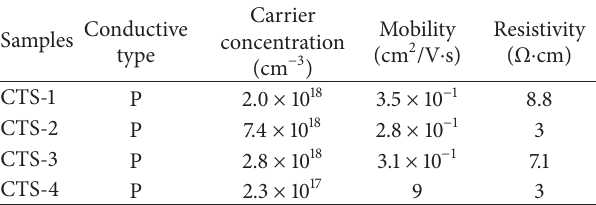
Figure 3: (a) Absorptance versus hv plot of the CTS-3 thin film. (b) The plots of ( 𝛼 hv ) 2 versus hv for estimating the direct band gap. Table 3: Electrical properties of the CTS thin films sulfurized at different